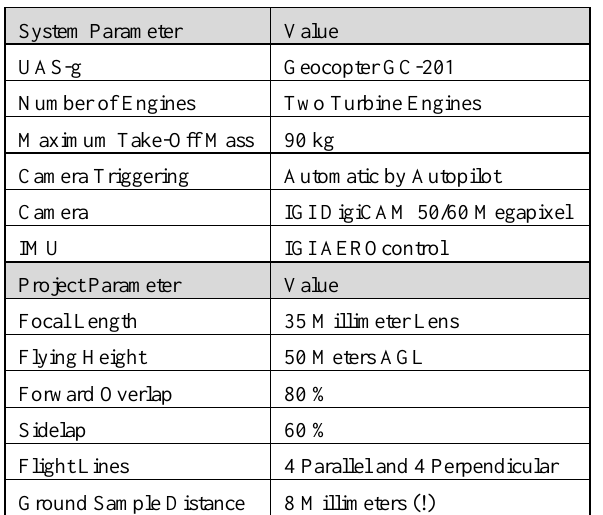
Figure 5. Entire Image (top) and Full Resolution